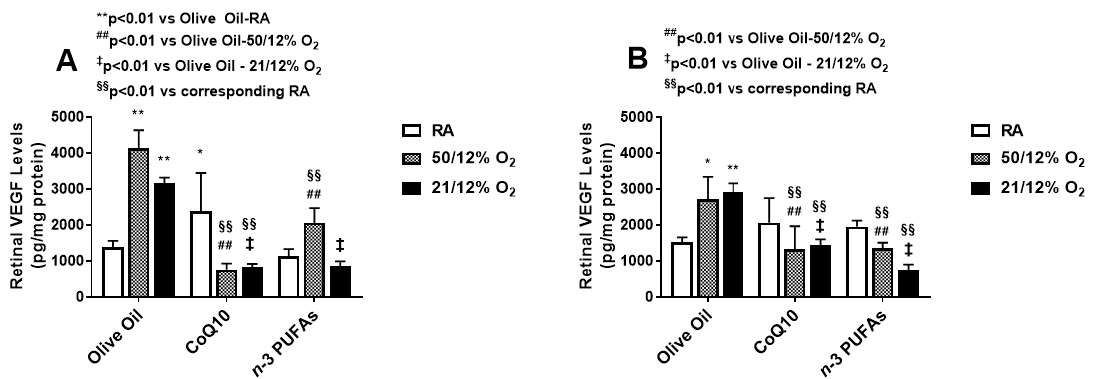
Figure 2. Effect of CoQ10 or n -3 PUFA supplementation in IH on retinal VEGF levels. Data are mean ± SD. n = six samples/group (* p < 0.05; ** p < 0.01 vs. olive oil in RA; ## p < 0.01 vs. olive oil in 50/12% O 2 ; ‡ p < 0.01 vs. olive oil in 21/12% O 2 ; and §§ p < 0.01 vs. corresponding treatment in RA). RA (room air); VEGF (vascular endothelial growth factor).